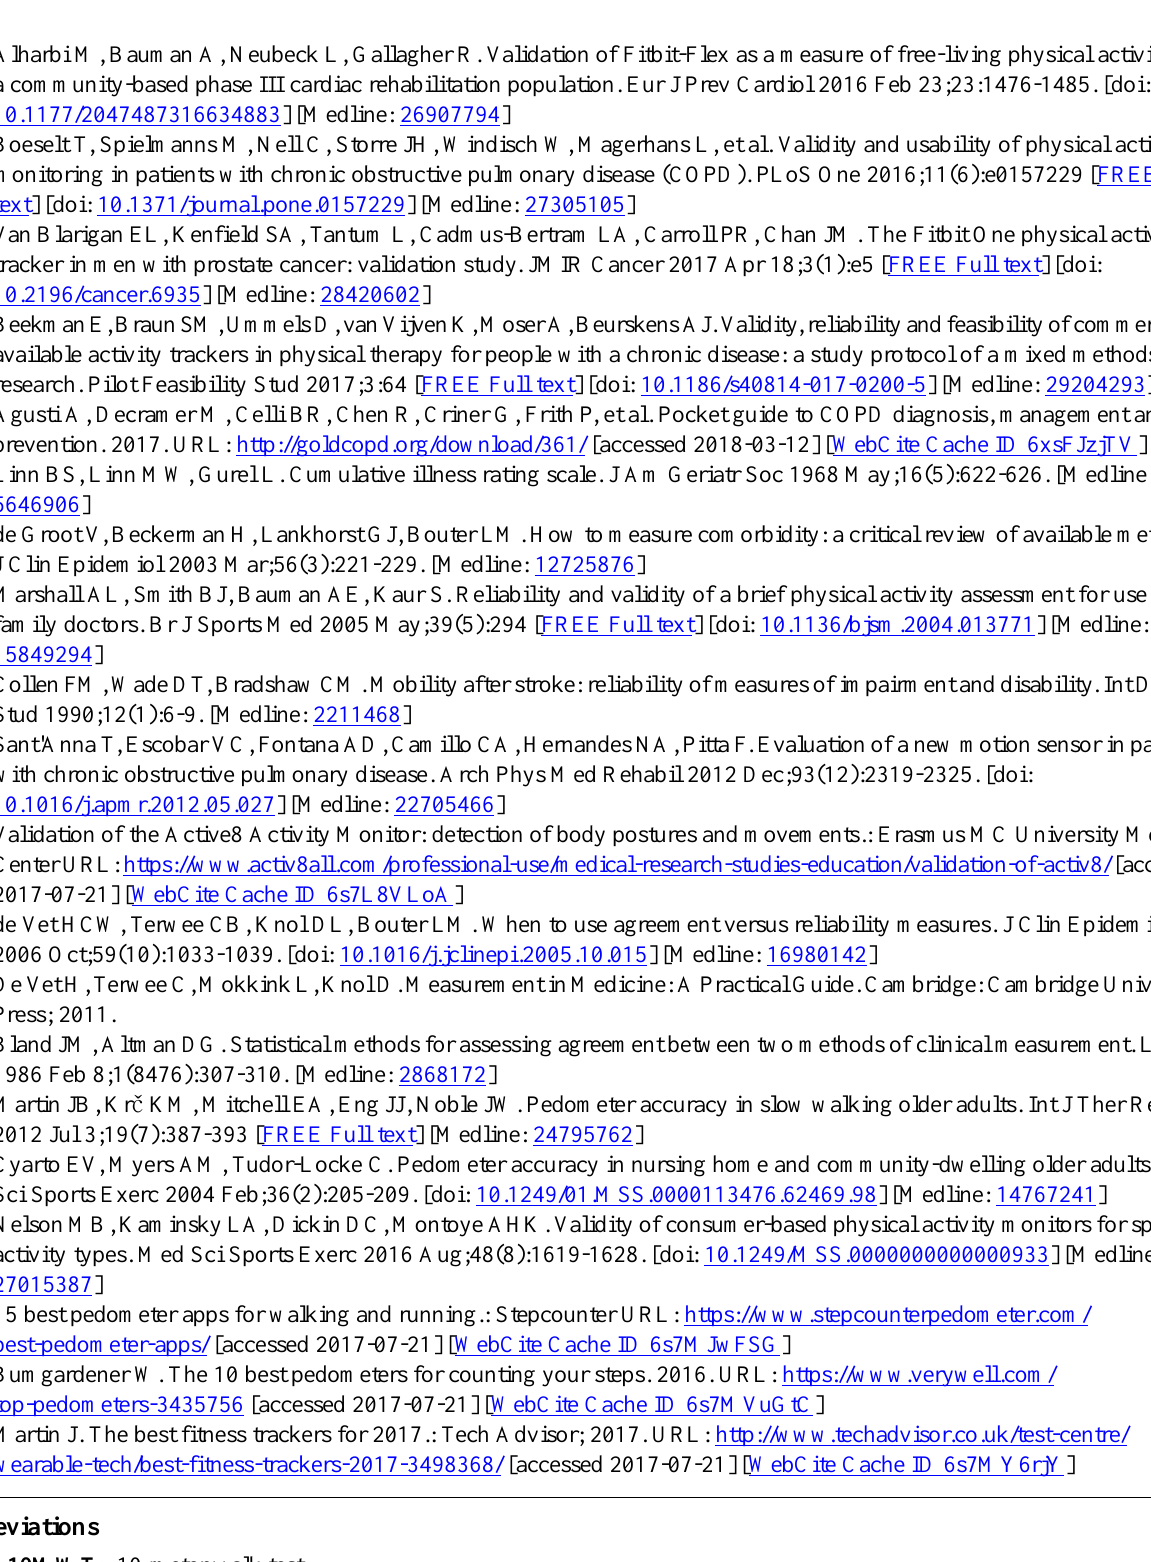
10MWT: 10-meter walk test CIRS: Cumulative Illness Rating Scale COPD: chronic obstructive pulmonary disease ICC: intraclass correlation